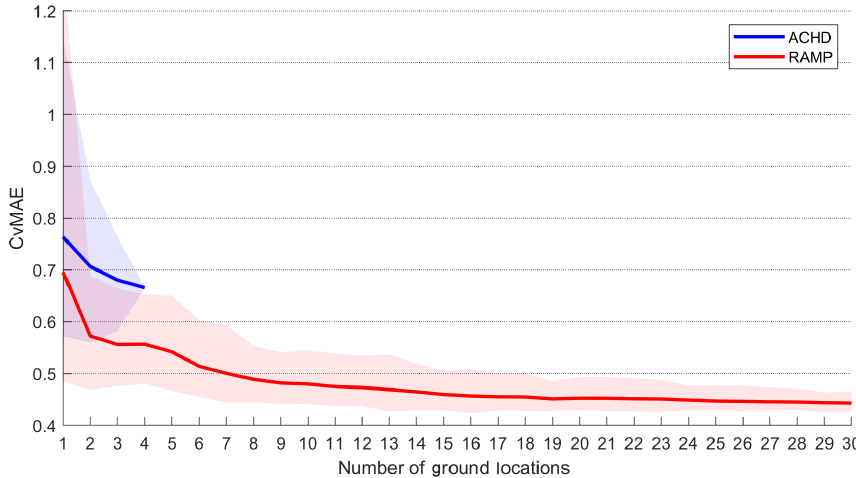
Figure 4. Performance (assessed in terms of CvMAE) for surface PM 2 . 5 estimated from satellite AOD data in the Pittsburgh area plotted as a function of the number of ground sites used. Performance is assessed against the ACHD regulatory-grade monitors. Solid lines indicate mean performance across sites using either ACHD or low-cost sensor (RAMP) sites to establish conversion factors. Shaded regions indicate the range of variability across application